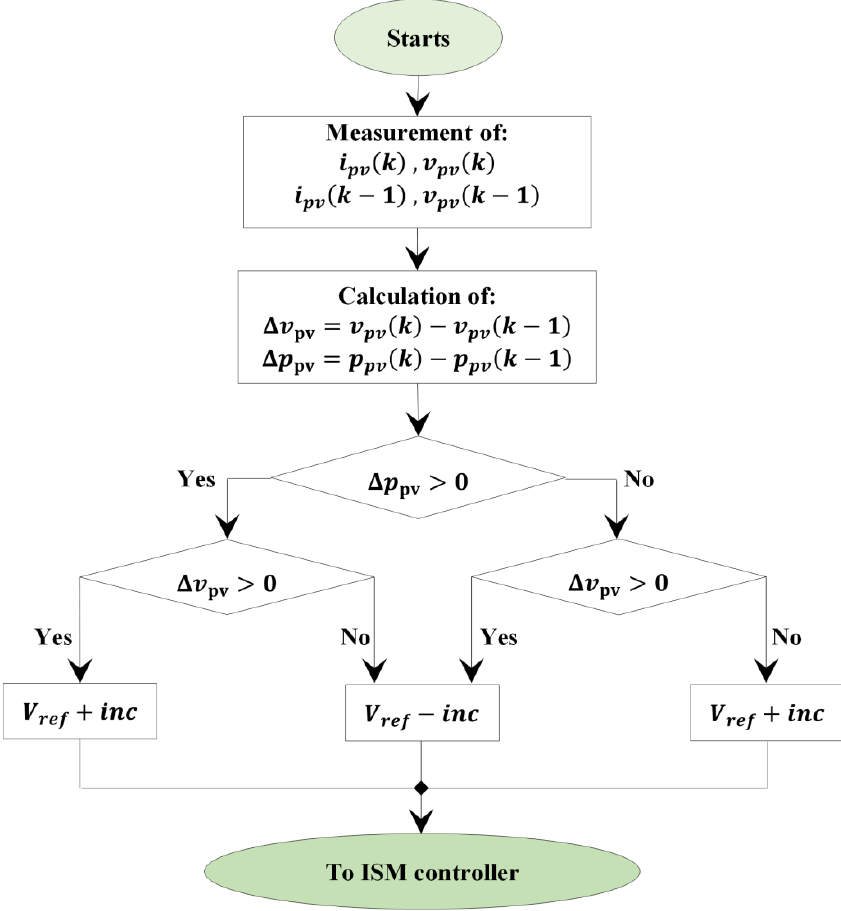
Figure 7. P&O-based V-MPPT flowchart.